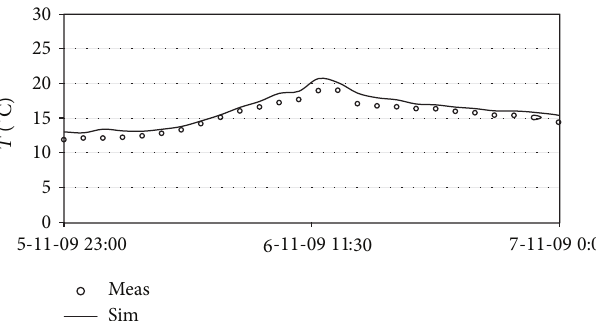
Figure 9: Variation in time of surface temperature on west fac¸ade in November 2009, with cloudy sky (measurements versus numerical